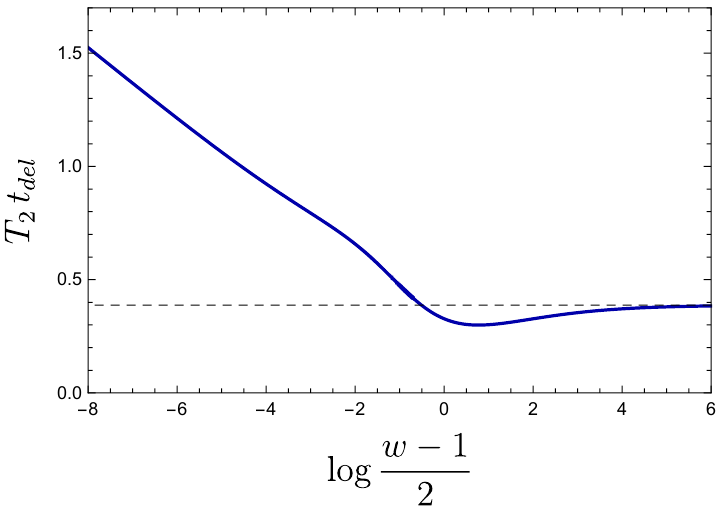
Figure 31. The delay time in eq. (B.28) as a function of log(( w is linear with a slope minus one, as is characteristic of the scrambling time in eq. (B.29). For heavy shock waves, t del approaches a constant at large w , as given in eq. (B.30).